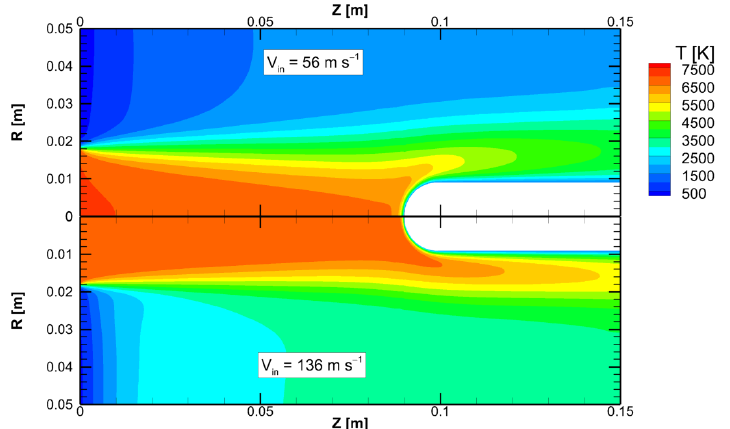
Figure 7. Temperature fields for cases with T in = 7000 K, ( top ) case 3 and ( bottom ) case 4.